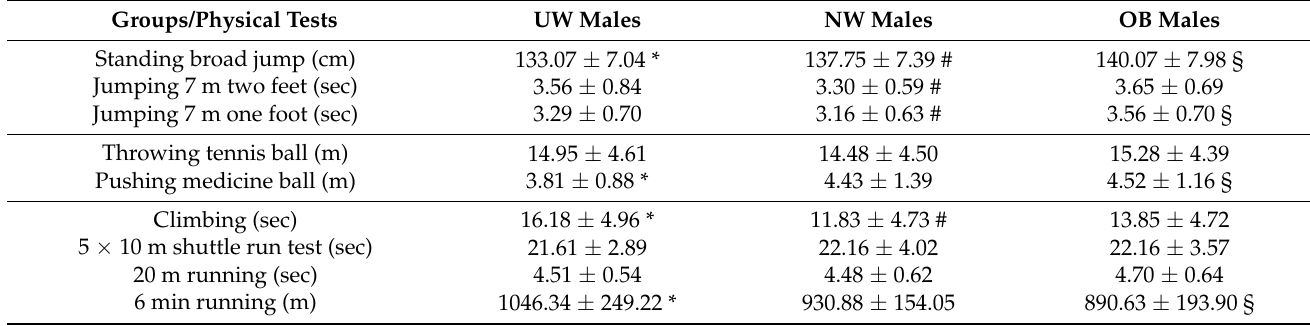
Table 4. Differences between groups of male participants in the physical fitness